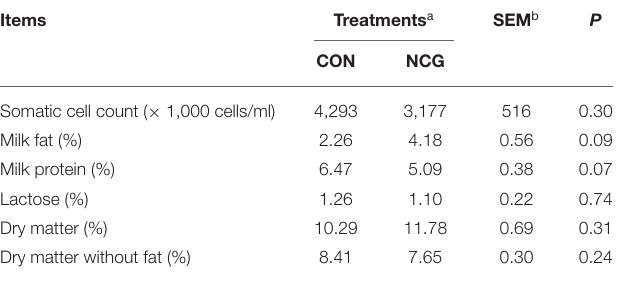
TABLE 3 | Effect of NCG on milk quality from experimental Jersey cattle.